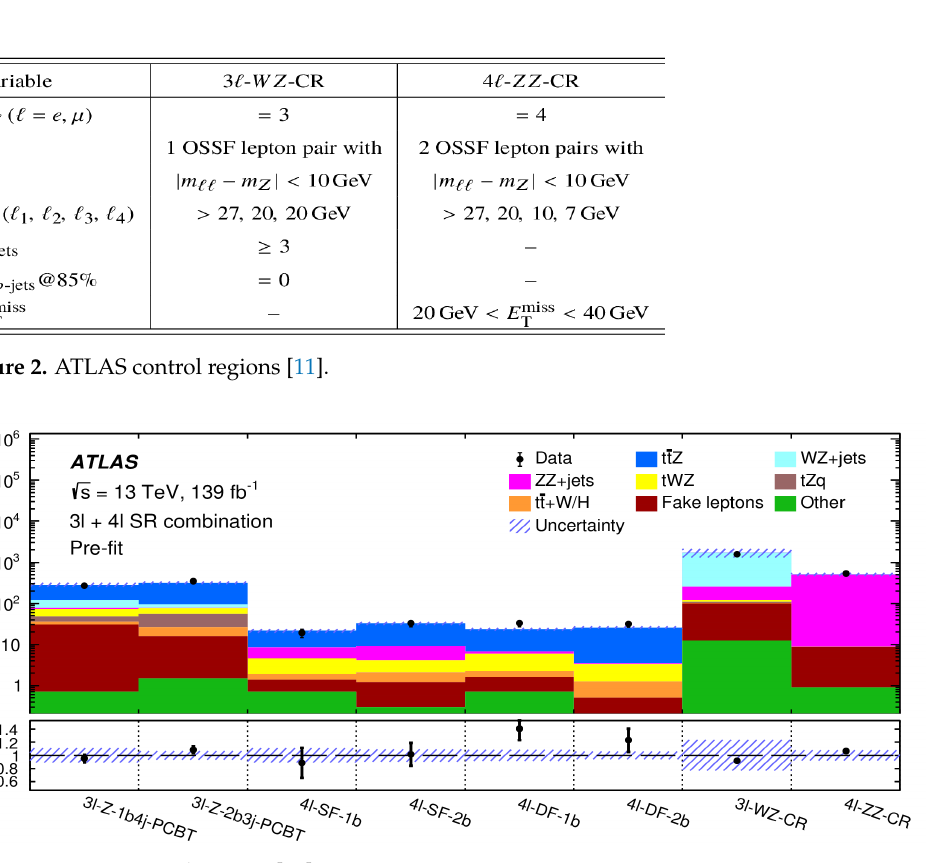
Figure 3. ATLAS signal regions [11].